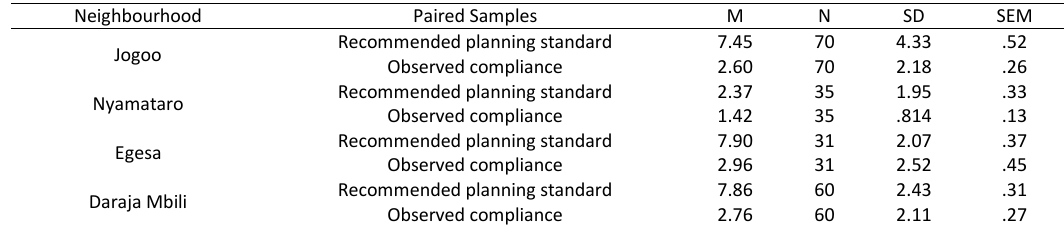
Table 3: Paired statistics - parking, Mwamosioma sub-location